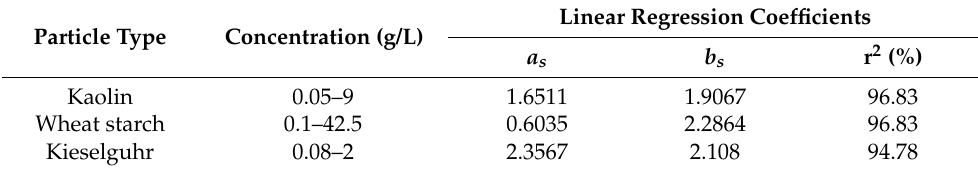
Table 3. Linear regression analysis for slope: δ = a s M + b s .